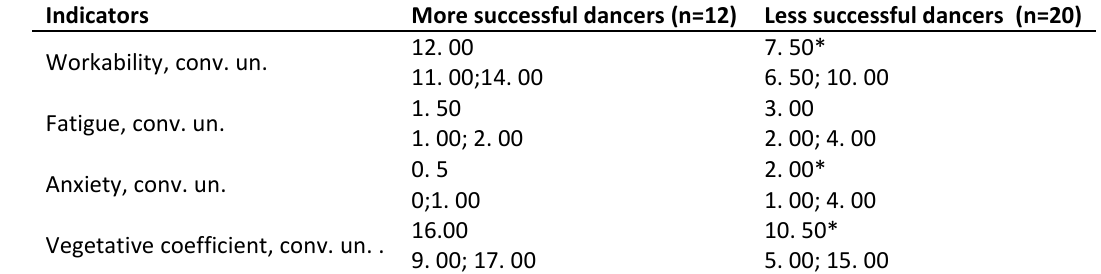
3. 00 2. 00; 4. 00 2. 00* 1. 00; 4. 00 10. 50* 5. 00; 15. 00